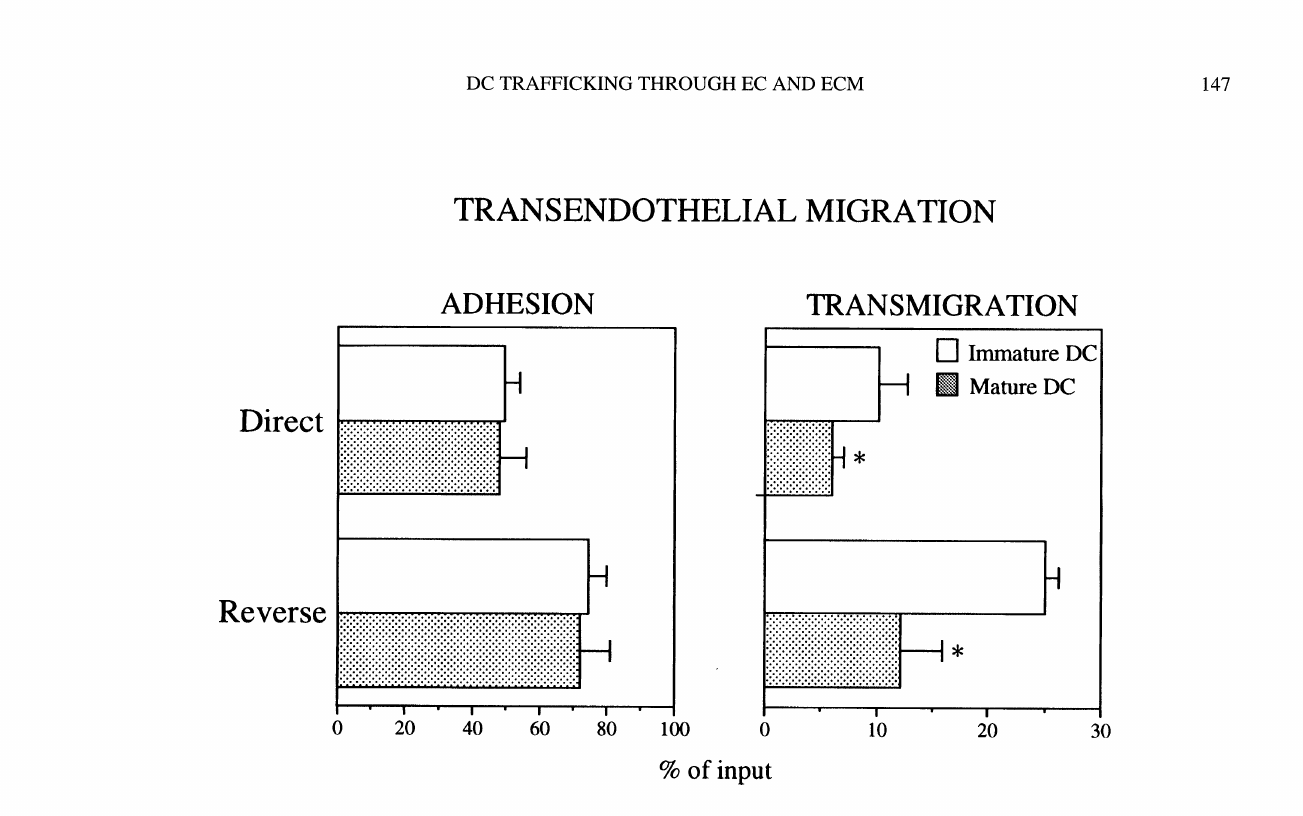
FIGURE 3 Effect of maturation on DC trans-endothelial migration. To induce maturation, immature DC were incubated with CD40L-trans- fected cells (CD40L) (5" ratio), for 48 h before being tested. 51Cr-labeled DC were seeded in the upper compartment. Radioactivity present in the lower compartment was evaluated after incubation at 37C for